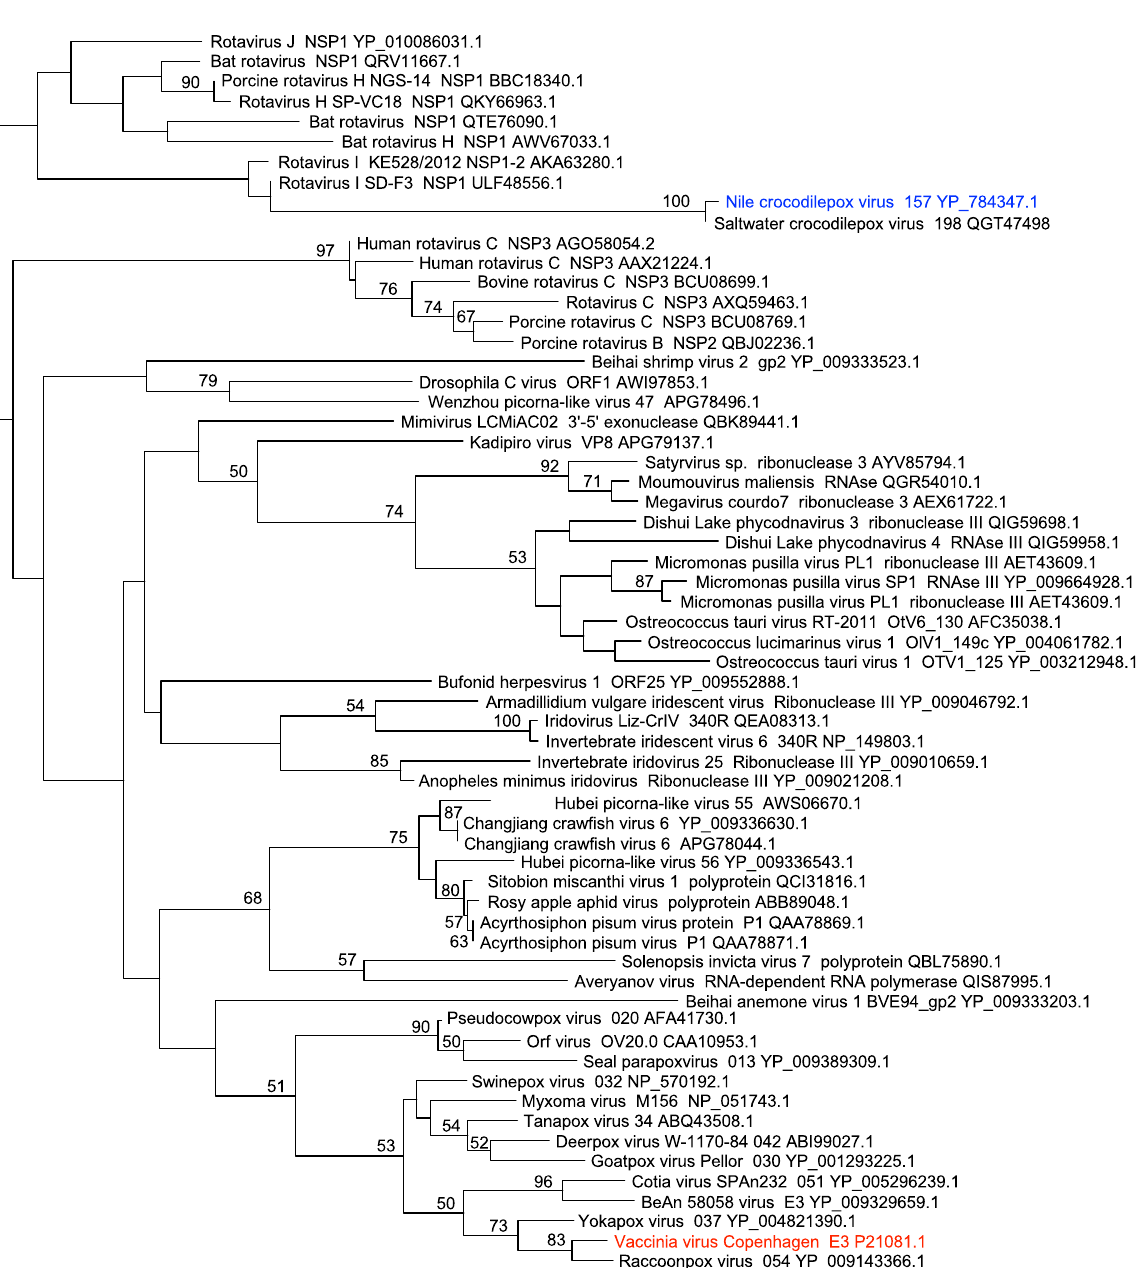
Figure 1. Phylogenetic relationship between viral dsRNA-binding domains. A maximum phylogenetic tree of dsRBDs from indicated viral proteins was constructed from a multiple sequence alignment generated with MUSCLE using PhyML. Numbers next to branches indicate bootstrap values ≥ 50. Accession numbers of proteins are indicated. The positions of CRV157 and VACV E3 are highlighted in blue and red, respectively.